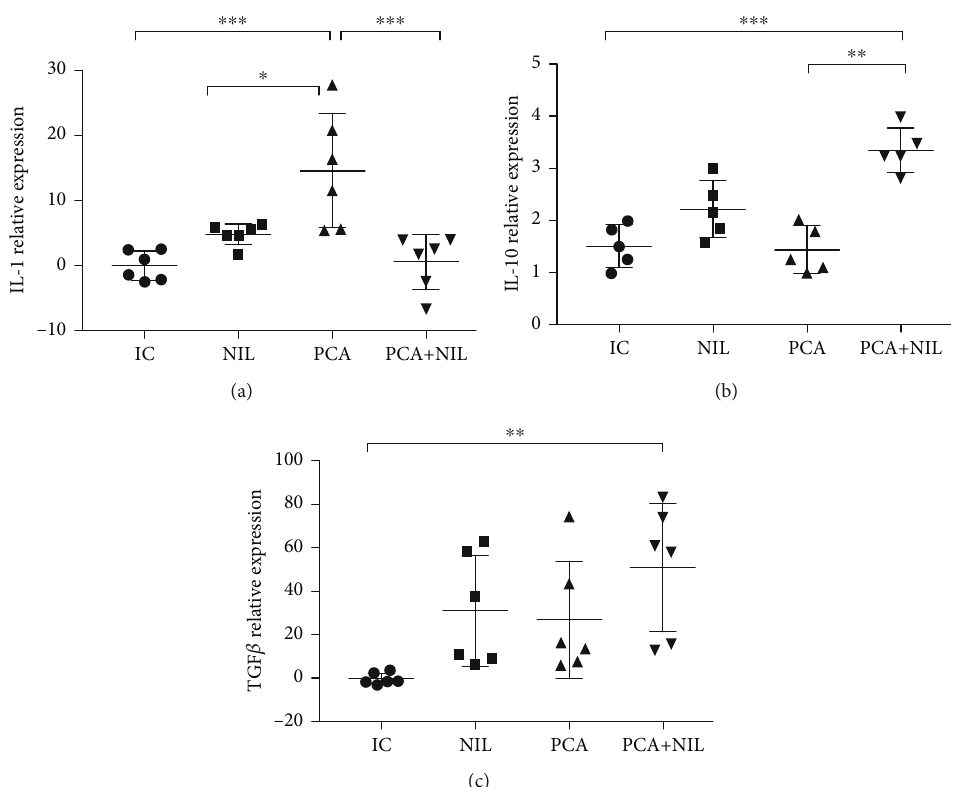
Figure 5: E ff ects of neurointermediate pituitary lobectomy (NIL), portacaval anastomosis (PCA), and PCA+NIL on the relative expression of (a) IL-1, (b) IL-10, and (c) TGF- β . (a) ∗∗∗ p < 0 : 001 : IC vs. PCA, ∗ p < 0 : 05 : NIL vs. PCA, and ∗∗∗ p < 0 : 001 : PCA vs. PCA+NIL. (b) ∗∗∗ p < 0 : 001 IC vs. PCA+NIL. (c) ∗∗ p < 0 : 01 : IC vs. PCA+NIL. The intact control (IC) group served as reference. It was evaluated with analysis of variance test with the Kruskal-Wallis test and Dunn ’ s post hoc values, which are expressed as the mean ± SD